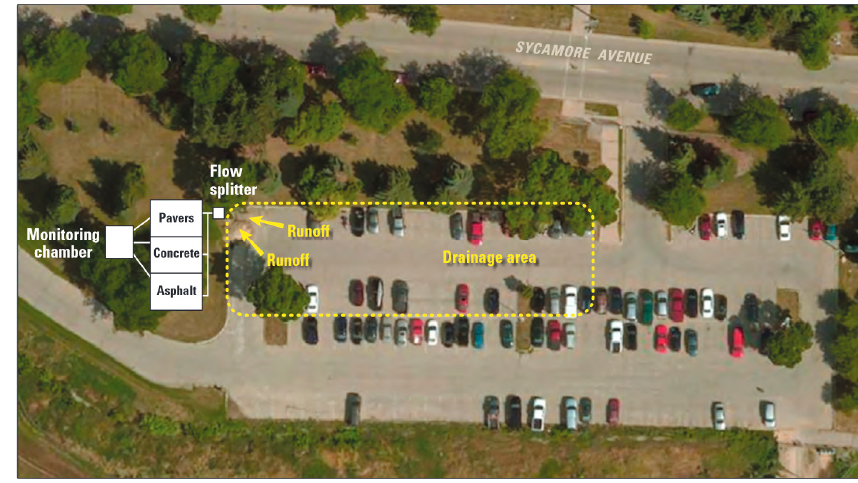
Water 2019 , 11 , x FOR PEER REVIEW Figure 15. Parking lot located in Madison, Wisconsin. Figure 15. Parking lot located in Madison, Wisconsin.